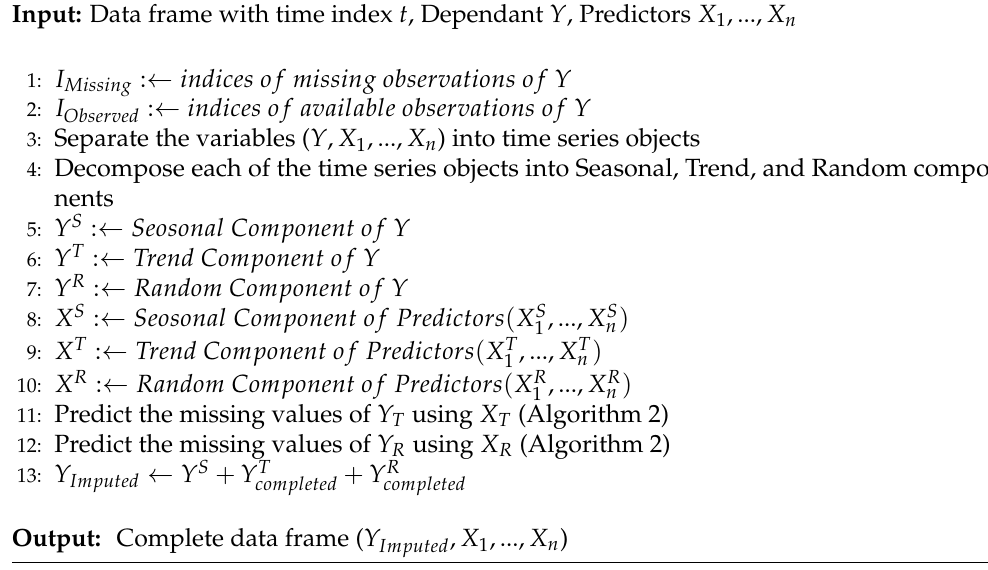
Algorithm 1 Main Imputation Algorithm